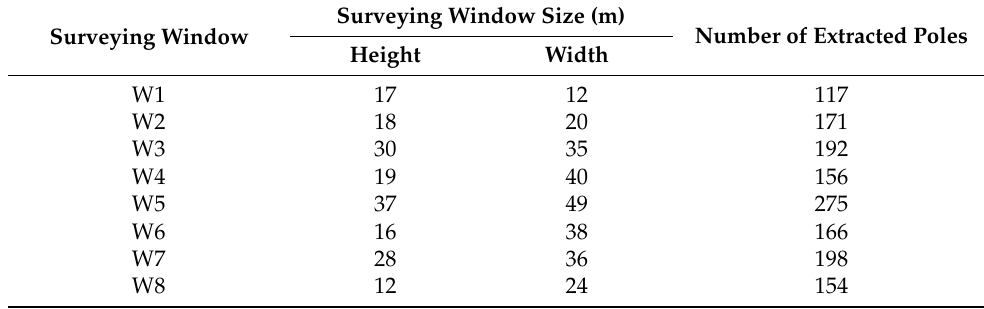
Table 1. Surveying windows’ size and number of discontinuity poles extracted by the dense point cloud. Surveying